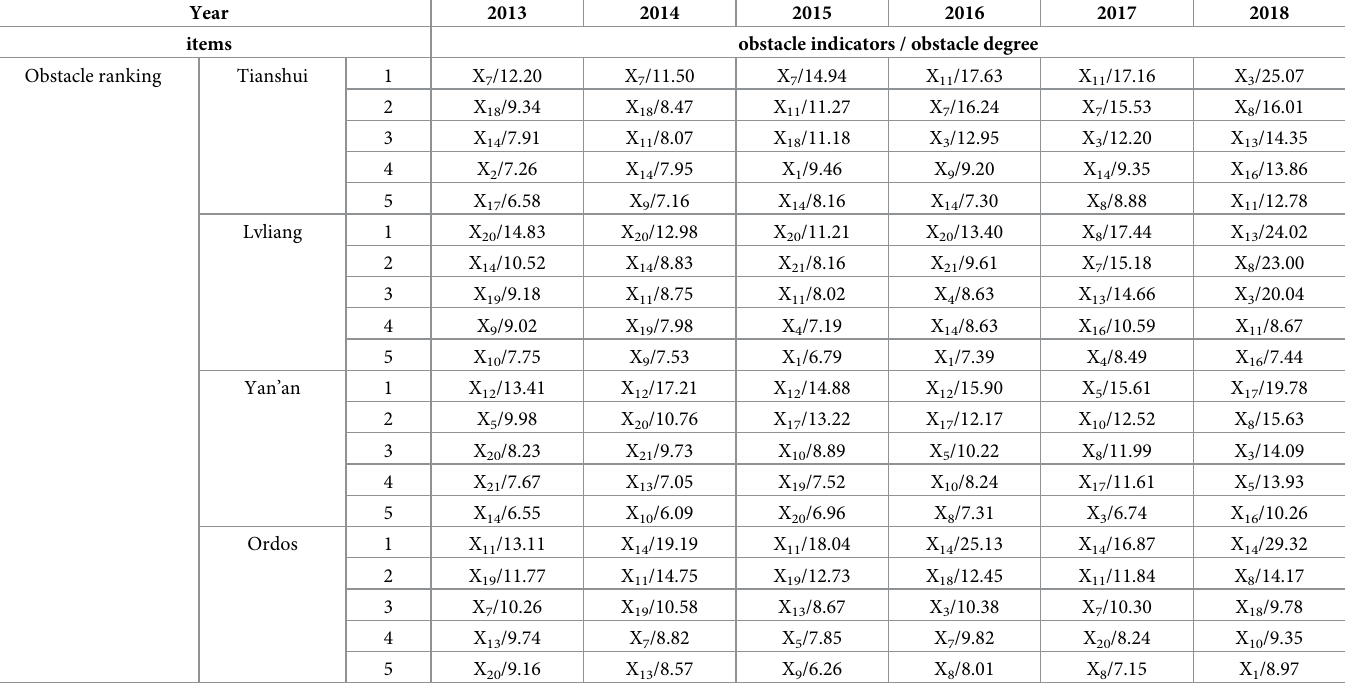
The results show that the carrying capacity of the economic subsystem of the Ordos Plateau is significantly higher than that of other natural areas. According to the latest data from the Table 4. Obstacle indicators for cities with negative resource and environmental carrying capacity growth from 2013 to 2018 (top five). Year 2013 Obstacle